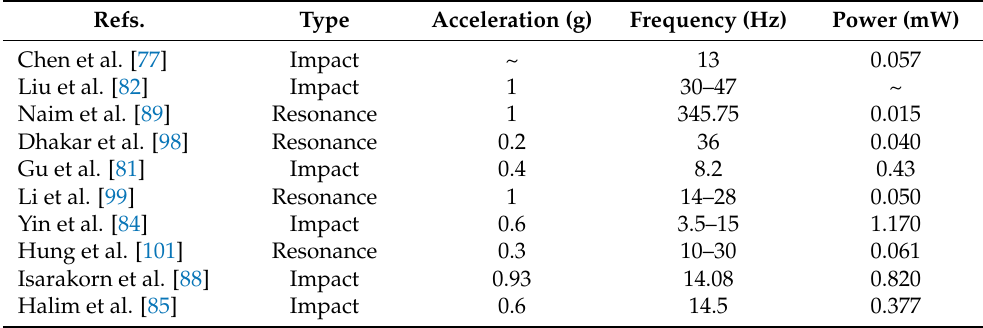
Table 2. Several different collection structure